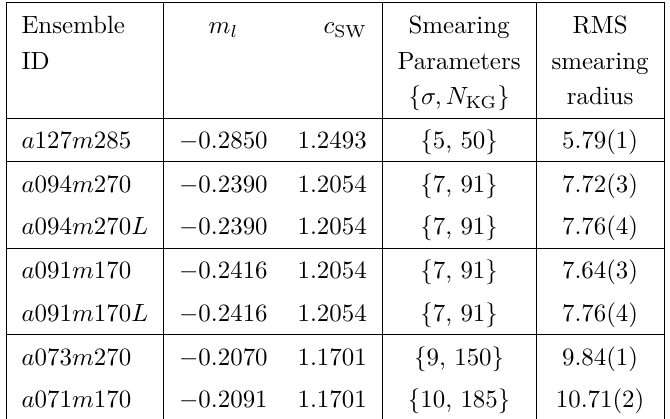
Table 2 . The parameters used in the calculation of the clover propagators. The hopping parameter for the light quarks, κ , in the clover action is given by 2 κ = 1 / ( m +4) . c is the Sheikholeslami- l l l SW Wohlert improvement coefficient in the clover action. The parameters used to construct Gaussian smeared sources [29], { σ, N in the Chroma convention [30], are given in the fourth column KG } where N is the number of applications of the Klein-Gordon operator and σ controls the width KG of the smearing. The resulting root-mean-square radius of the smearing in lattice units, defined as q R dr r 4 S † S/ R dr r 2 S † S with S ( r ) the value of the smeared source at radial distance r , is given in the last